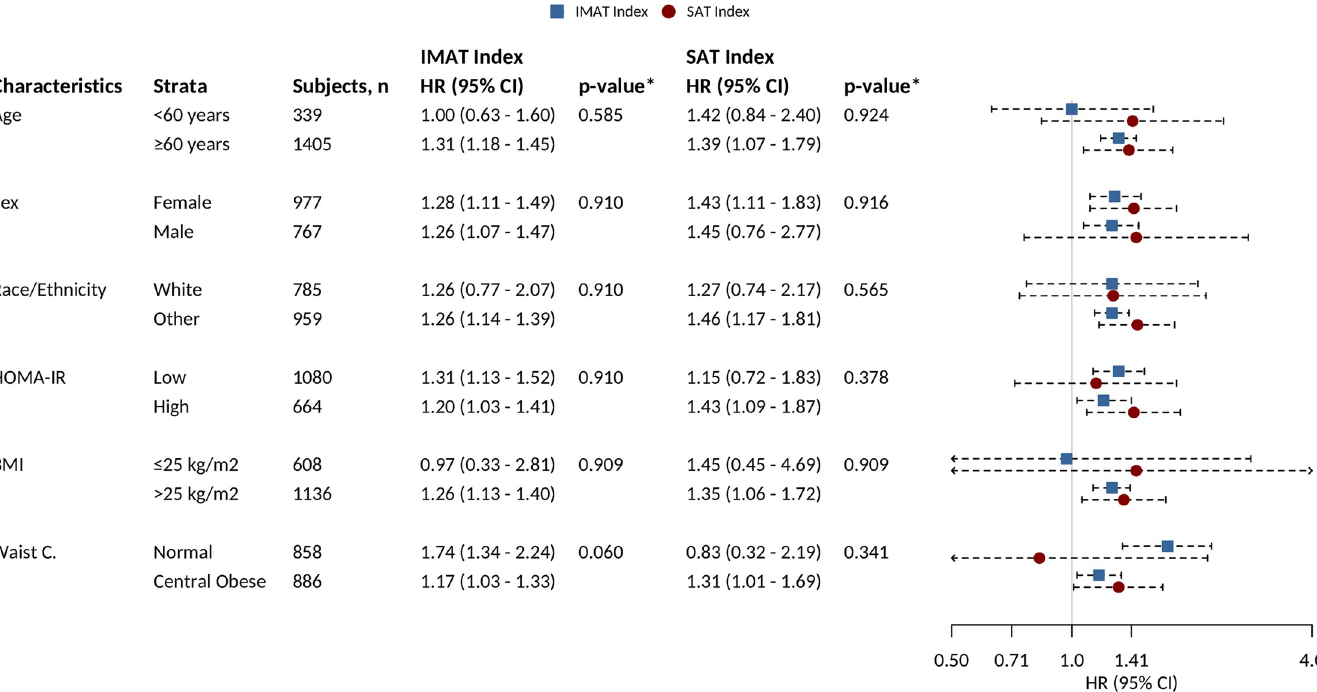
Fig 2. Forest plot of the associations of adipose tissue biomarkers and T2D incidence by stratification variables. � p -value for interaction. Models were adjusted for covariates in Model 1 (categorical age, sex, race/ethnicity, smoking status, alcohol drinking status, physical activity, TG, HDL cholesterol, and hypertension), except for the stratification variable. Reported p -values were corrected for multiple comparisons. BMI, body mass index; CI, confidence interval; HDL, high-density lipoprotein; HOMA-IR, homeostatic model assessment–insulin resistance; HR, hazard ratio; IMAT, intermuscular adipose tissue; SAT, subcutaneous adipose tissue; T2D, type 2 diabetes; TG, triglyceride; Waist C., waist